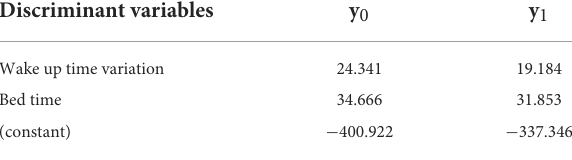
TABLE 5 Fisher function coefficients of 6–9 months age group.